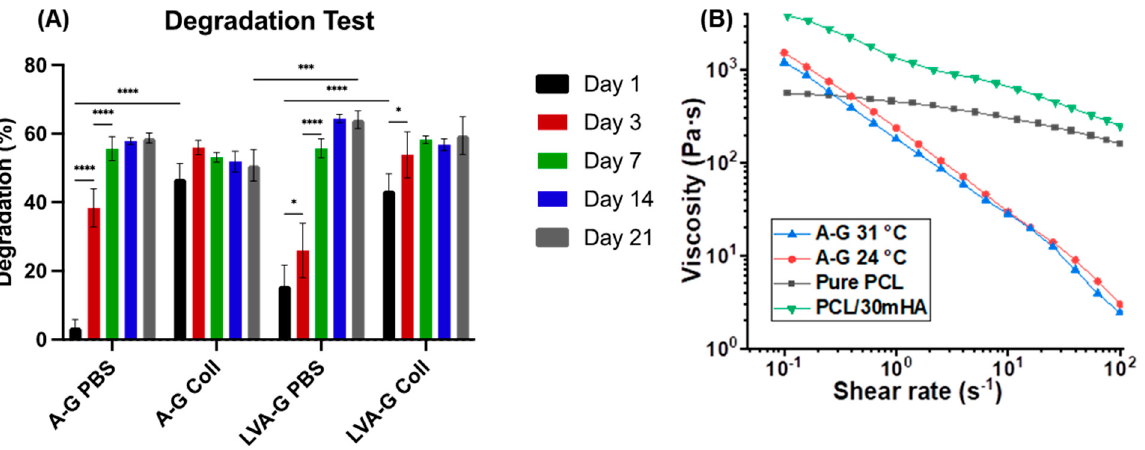
Figure 2. ( A ) Degradation test of the alginate–gelatin bioinks with PBS and collagenase for up to 21 days. * p < 0.05, *** p < 0.001, **** p < 0.0001. ( B ) Shear viscosity profile of the A − G bioink at 24 °C and 31 °C, and pure PCL ink and PCL/30HA ink for DIW at room temperature.